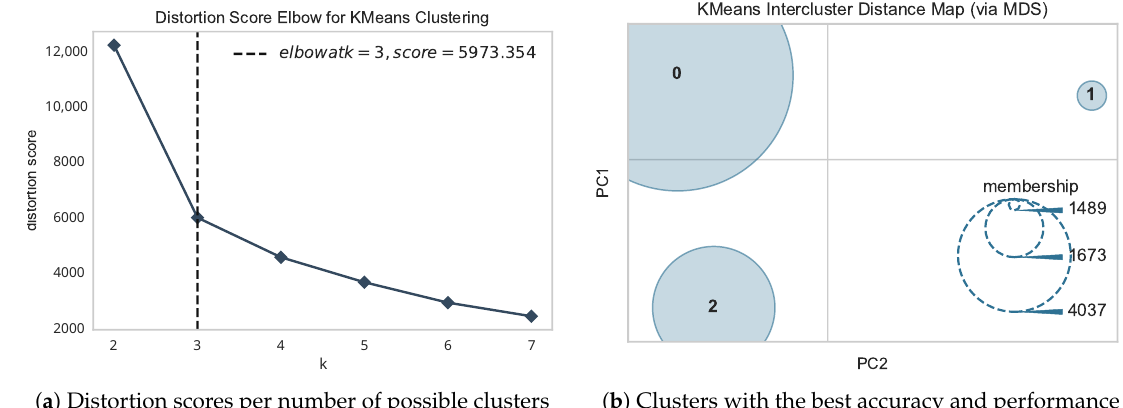
Figure 4. Application of K-Means to generate groups of suspects.